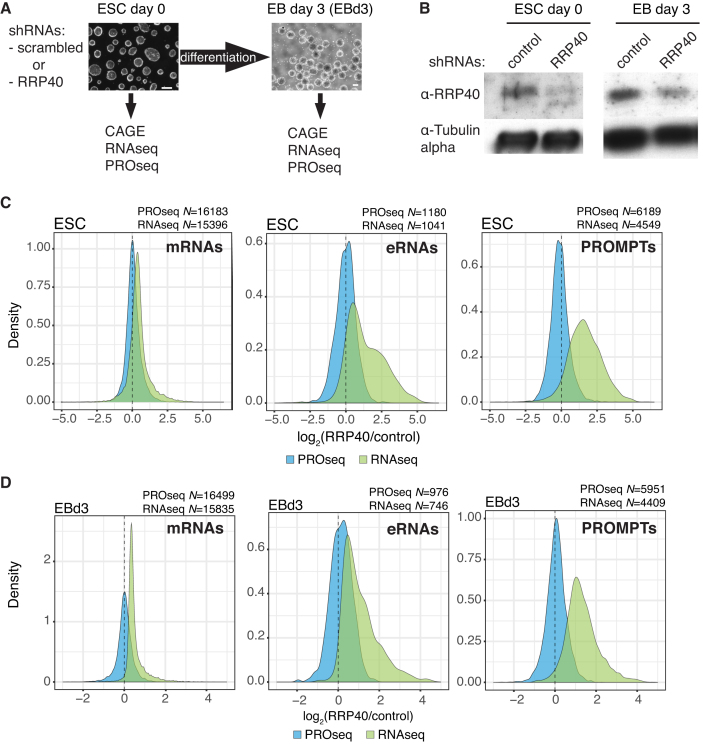
Effects of RRP40 depletion in ESCs and EBs. (A) Schematic representation of the experimental procedure and data collection. Scrambled control or RRP40-specific shRNAs were introduced using lentiviral vectors into ESCs, after which cells were differentiated into EB for 3 days. From each cell state and shRNA condition, CAGE, RNAseq and PROseq data were collected. The scale bar on the lower right corner of the images represents 100 μm (ESC) and 200 μm (EBd3). (B) Western blotting analysis of RRP40 levels in ESCs treated with the indicated shRNAs and differentiated for 0 (left) or 3 (right) days. Tubulin was used as a loading control. (C) Distributions (y-axis) of log2 fold changes (x-axis) between RNAseq (green) or PROseq (blue) values from RRP40-depleted versus control ESC samples. The RNA types measured and their numbers are indicated above each panel. The average of all replicates is shown. (D) As in (C) but for the EBd3 samples.